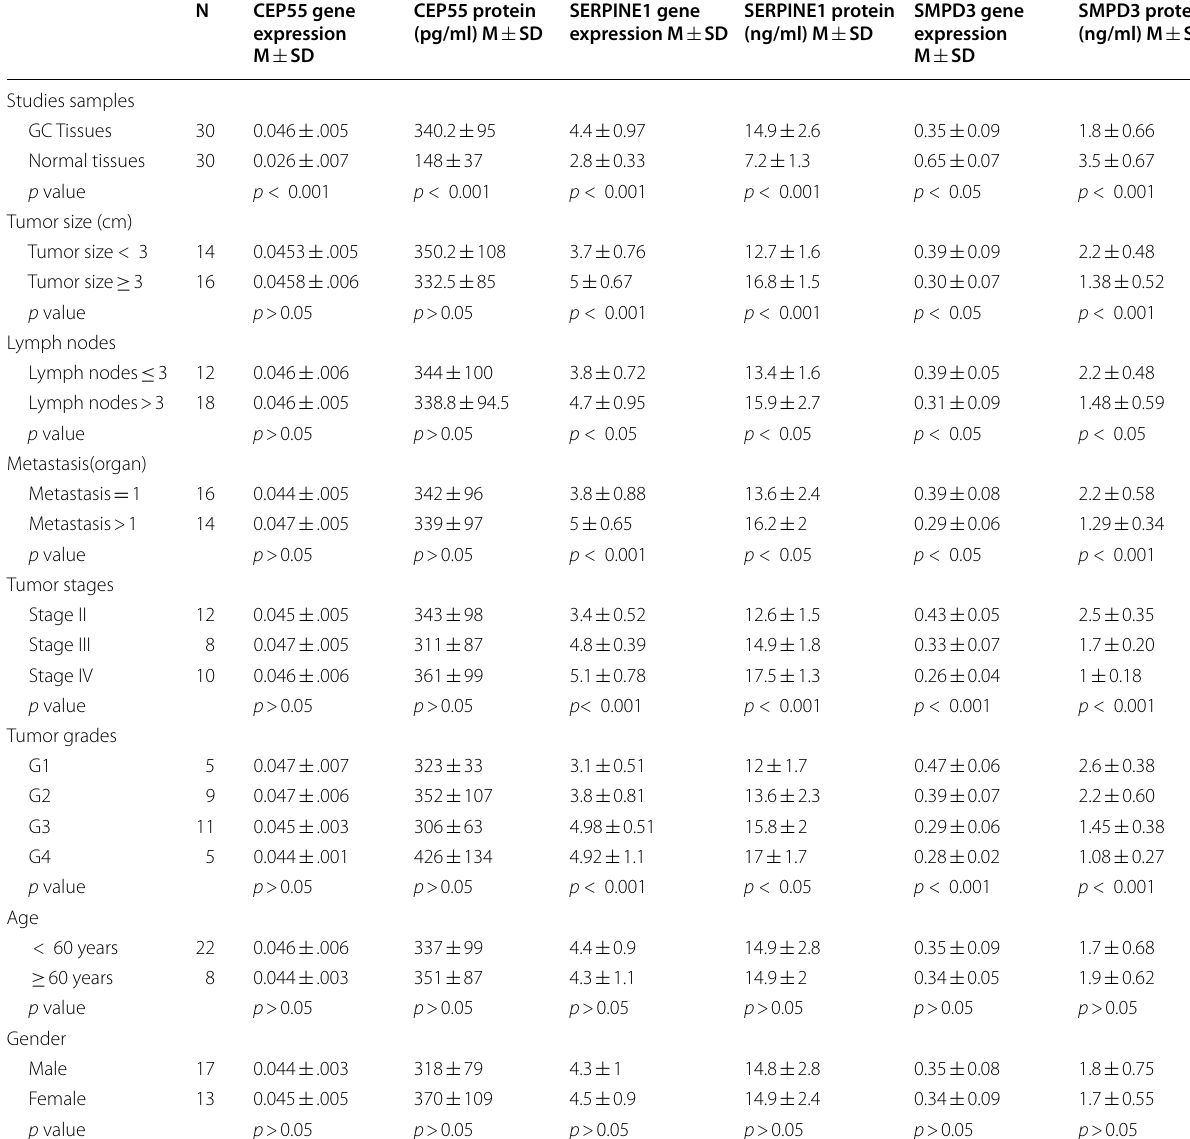
Table 2 Relations between the studied parameters, the demographic data and the tumor progression